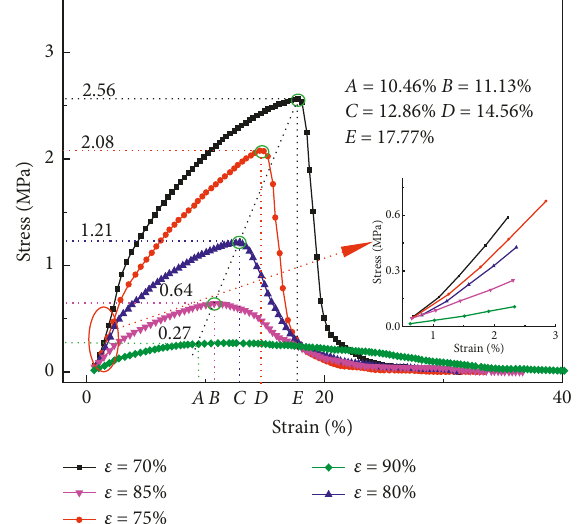
Figure 7: Uniaxial tensile stress-strain curves of PCFSSs with different